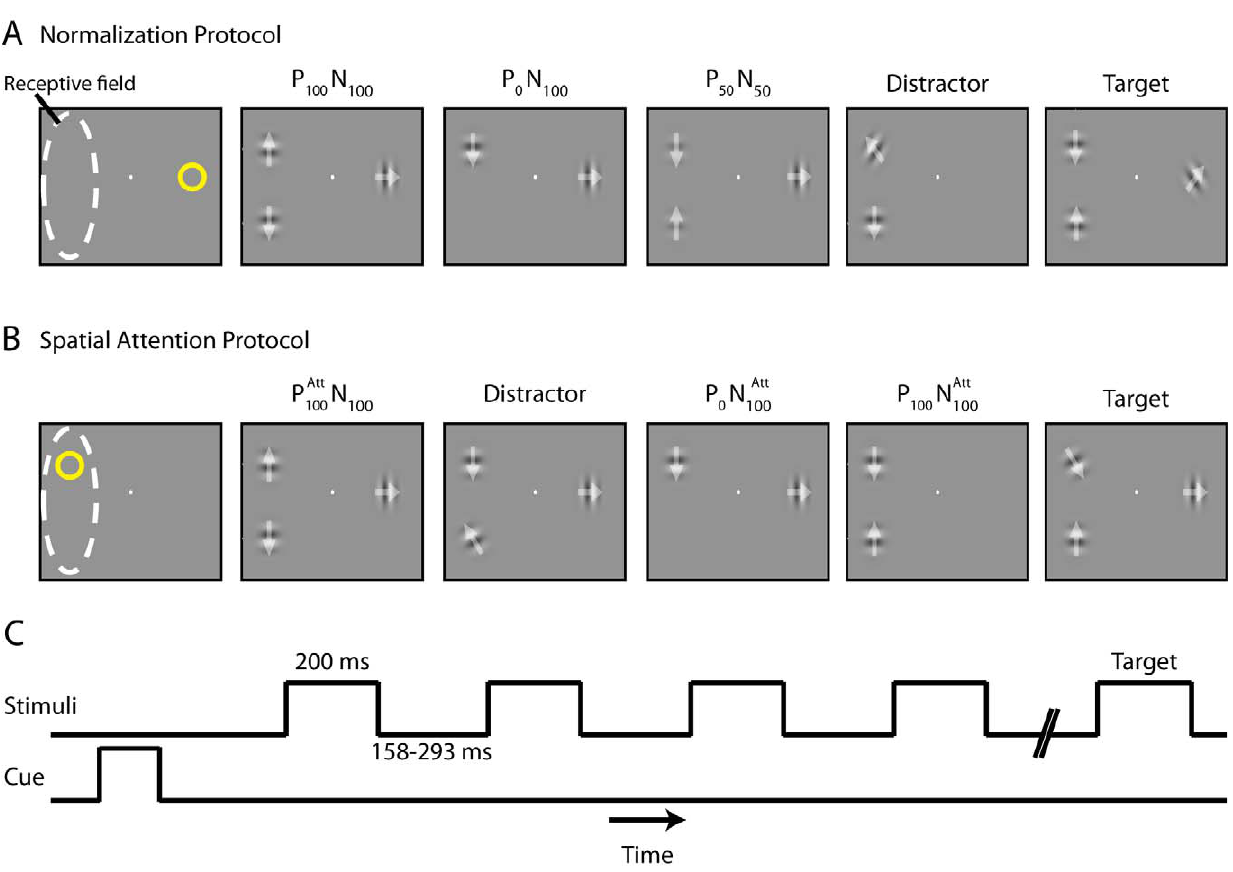
Figure 1. Experiment design. A series of drifting Gabor stimuli was flashed at each of three locations: two within the receptive field of the MT neuron being recorded and one outside the receptive field. The two stimuli inside the receptive field moved in the cell’s preferred and null directions, the stimulus outside moved in the intermediate direction. The monkey was cued to attend to one of the three locations and was required to detect a change in the direction of the cued Gabor. (A) ‘‘Normalization Protocol’’: The monkey attended outside the receptive field while the preferred and null stimuli were presented at 0%, 50%, or 100% contrasts, thus creating nine stimulus conditions. (B) ‘‘Spatial Attention Protocol’’: The monkey attended to one of the locations inside the receptive field. (C) Time line of the protocols. See Materials and Methods for details.